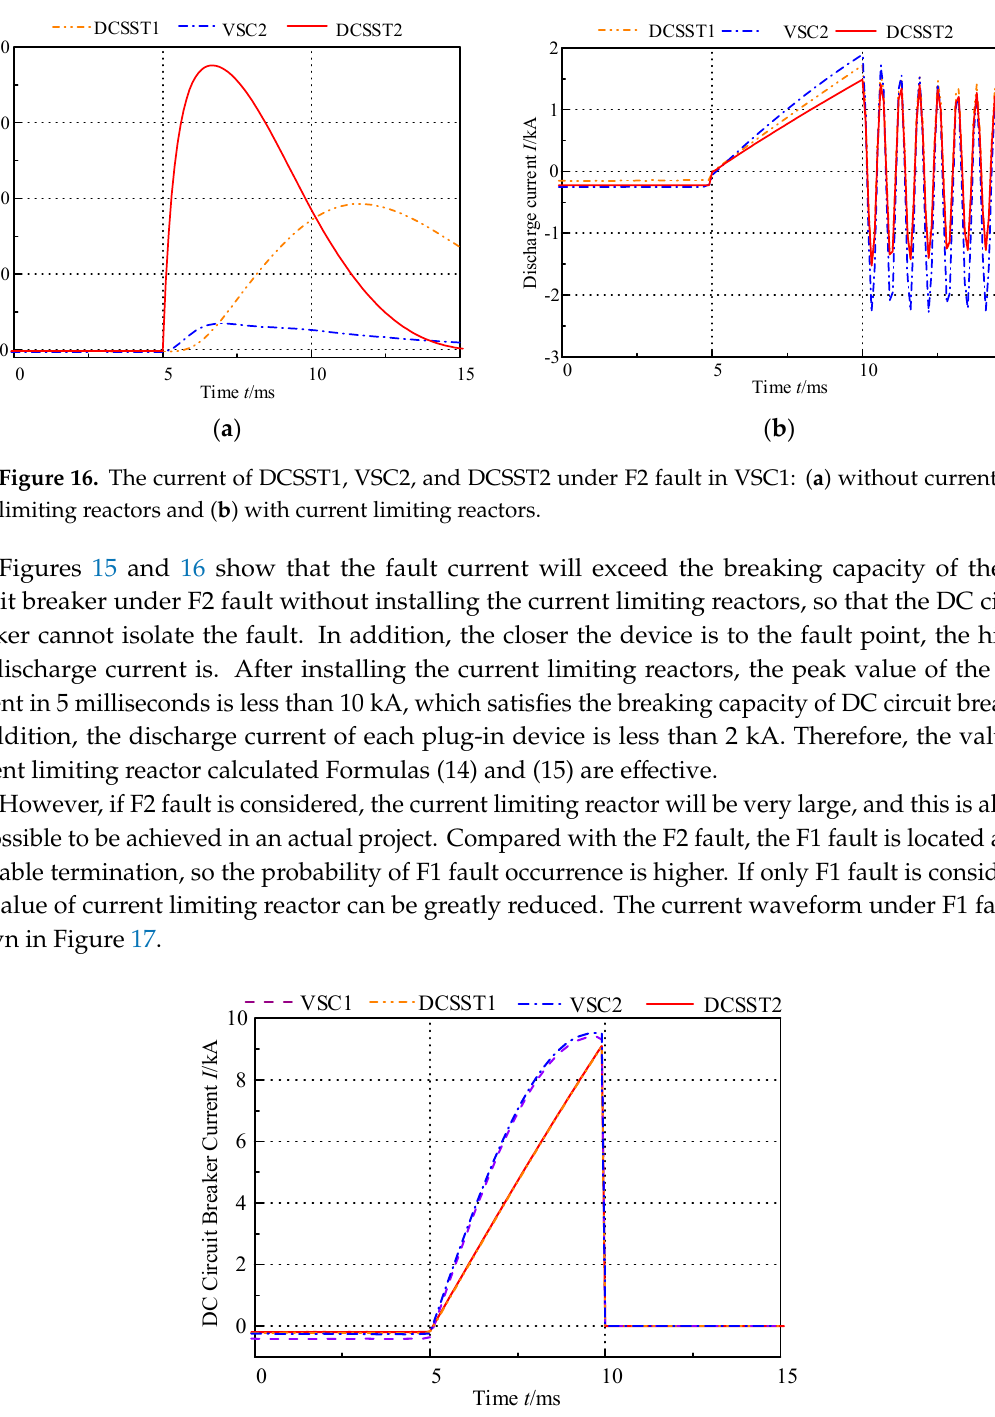
limiting reactors and ( b ) with current limiting reactors.